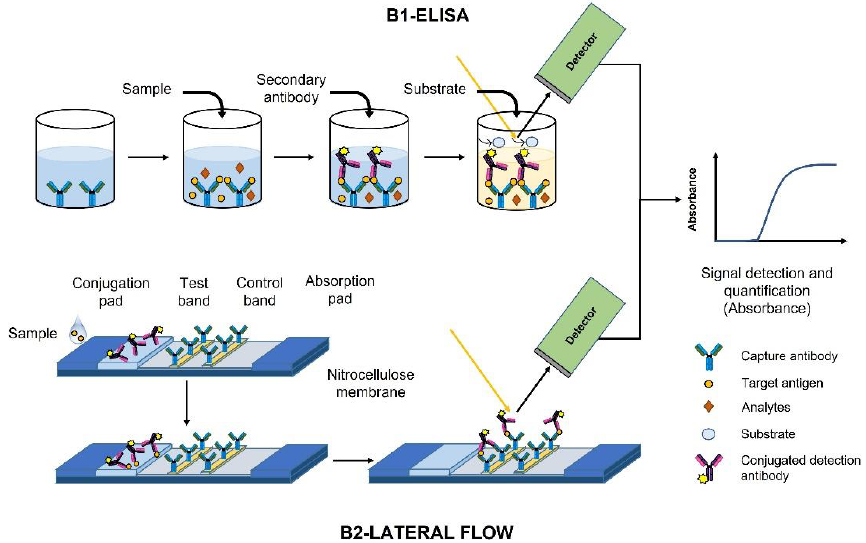
Figure 11. Classification based on the monitored changes in the imaginary part of the refractive index. B1 — ELISA ( top ) and B2 — Lateral Flow ( bottom ). B1—ELISA ( top ) and B2—Lateral Flow ( bottom